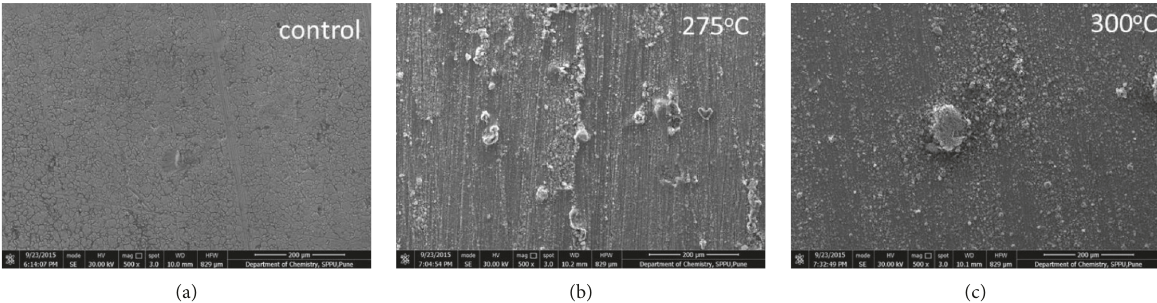
Figure 8: SEM images of coupon surface (a) without deposit (b) with deposit at 275 ° C (c) with deposit at 300 ° C. 275°C